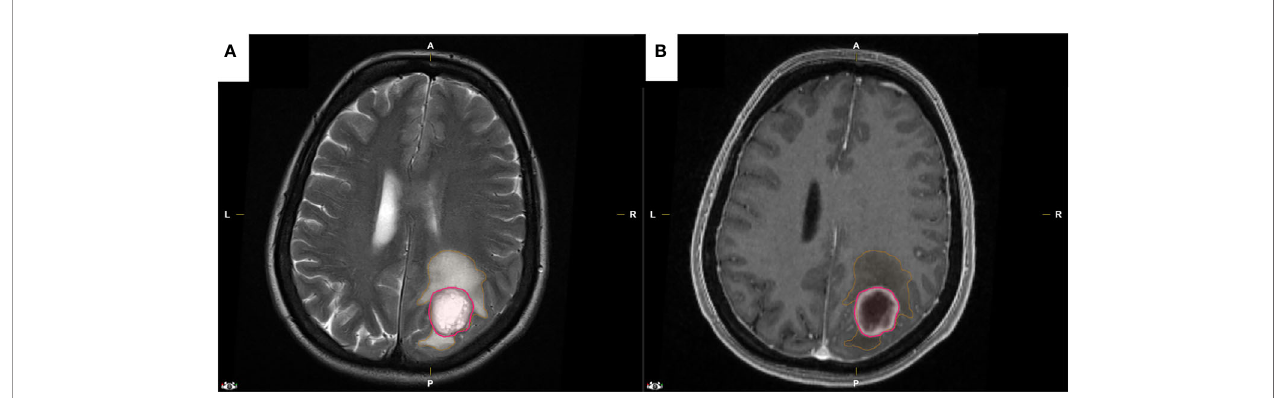
FIGURE 1 | Representative MRI images that were used for the semi-automatic segmentation with IPlannet 3 software by Brainlab ® . (A, B) Preoperative axial T2 and gadolinium enhanced T1 weighted MRI of a GBM patient with peritumoral edema encircled in orange and with tumor enhancement encircled in